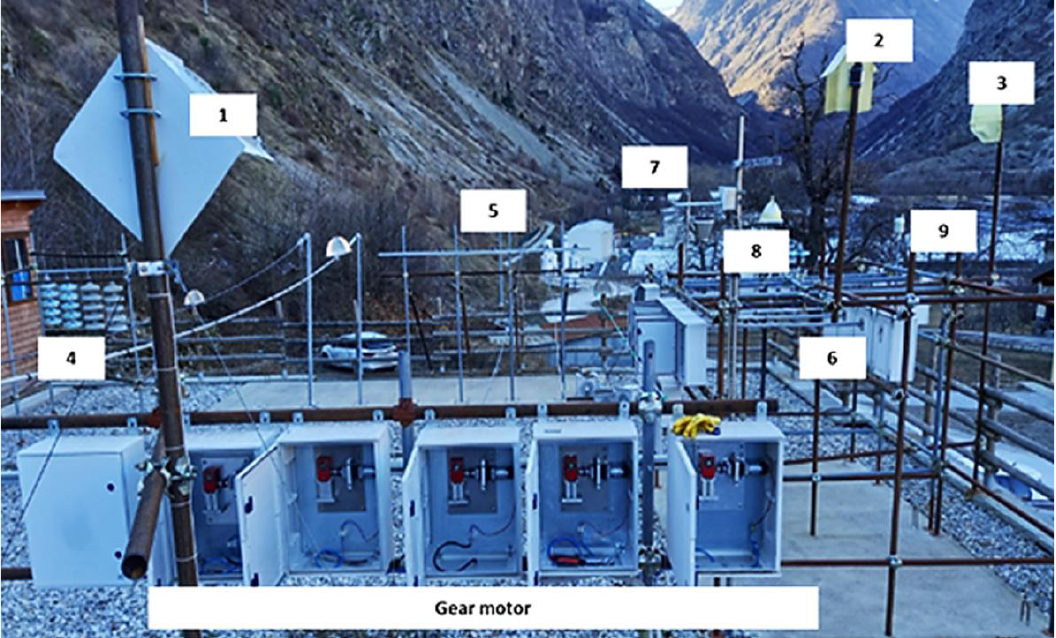
Figure 1. WILD station and the equipment. 1,2,3: webcam motobix; 4: insulator testing station; 5: 15 mt span conductor testing station; 6: 1.5 mt pieces conductor testing station; 7: anemometer; 8: rain gauge; 9: Vaisala multisensor.